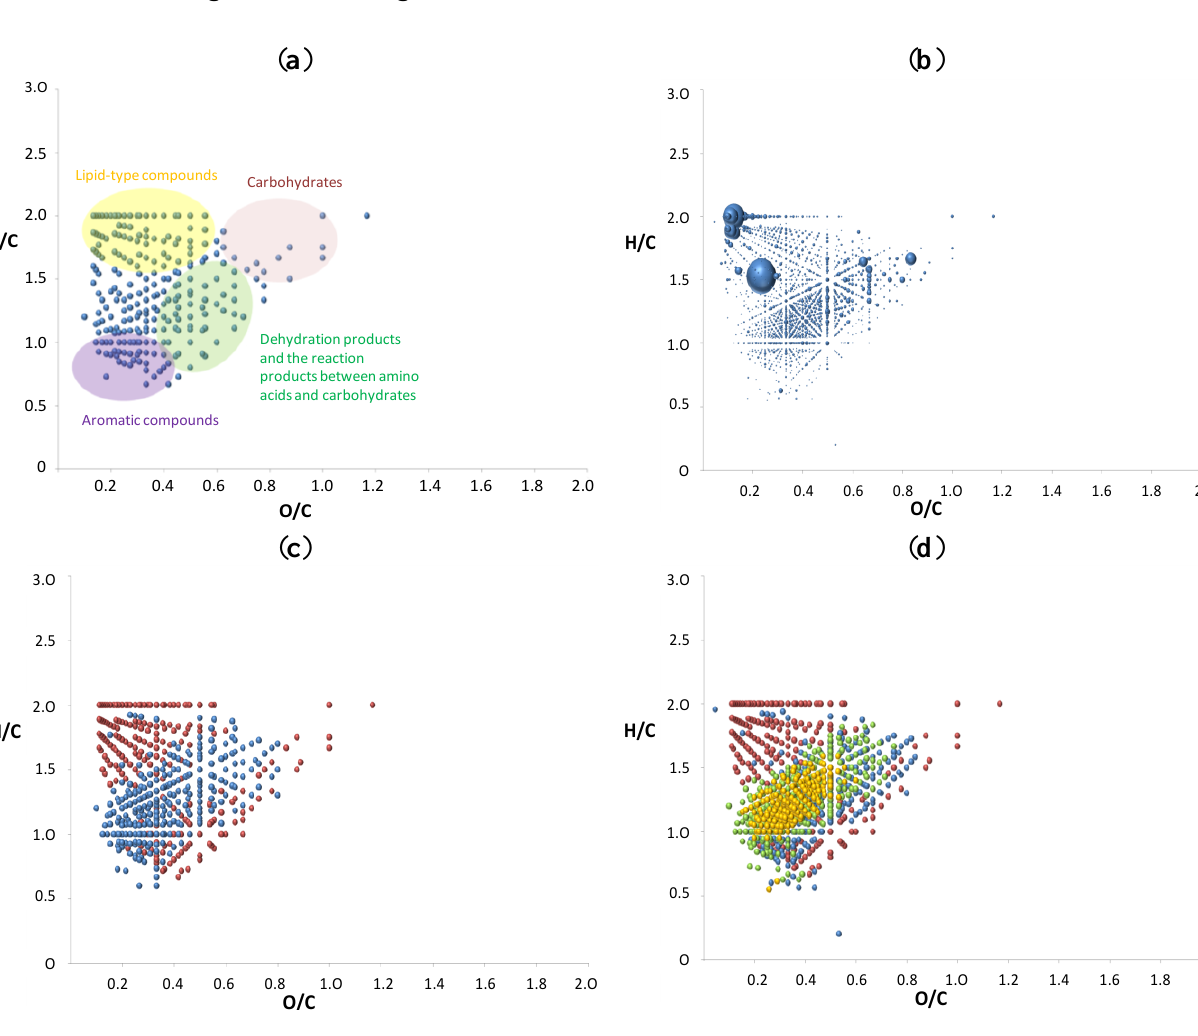
Figure 5. The van Krevelen diagrams of the reaction of sucrose with serine: ( a ) with colored groups of compounds; ( b ) with the intensities; ( c ) with nitrogen-free (red points) and nitrogen-containing compounds (blue points); ( d ) with nitrogen-free (red points) compounds and one nitrogen atom (blue points), two (green), three (yellow) and four (violet) nitrogen atoms in negative ion